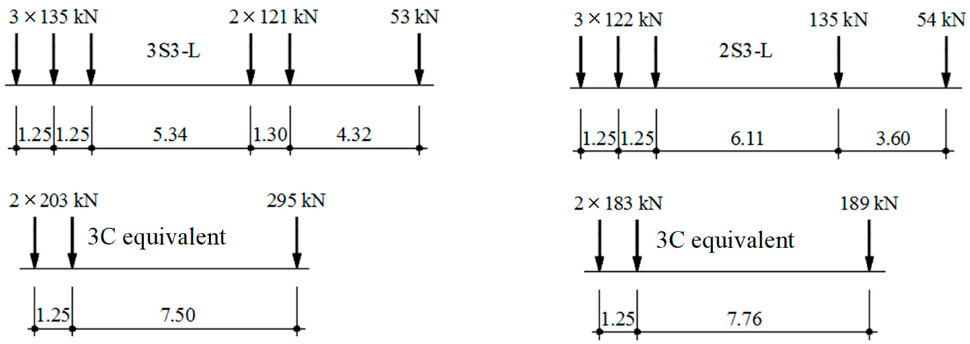
Figure 7. Some 3C-equivalent trucks. Units: m.